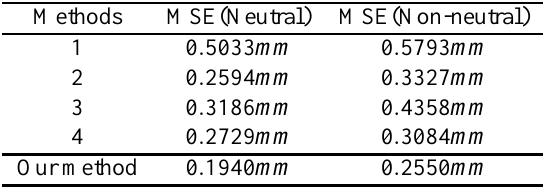
Table 2. Comparison the MSE between faces belonging to the same individual by using different face alignment approaches in (within class performance).